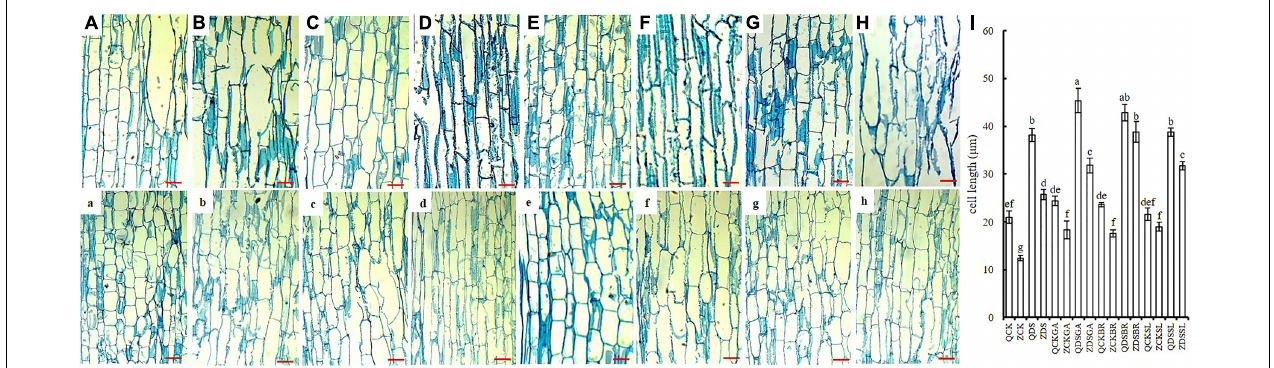
FIGURE 2 | The longitudinal structure of mesocotyl in different maize inbred lines under different treatments. The top row shows Qi319 in treatment groups (A) CK, (B) DS, (C) CKGA, (D) DSGA, (E) CKBR, (F) DSBR, (G) CKSL, (H) DSSL, and (I) cell length in two inbred lines under each treatment. (a–h) The bottom row shows the same order of treatment groups as A-H for Zi330. All bars are 12 µ m.